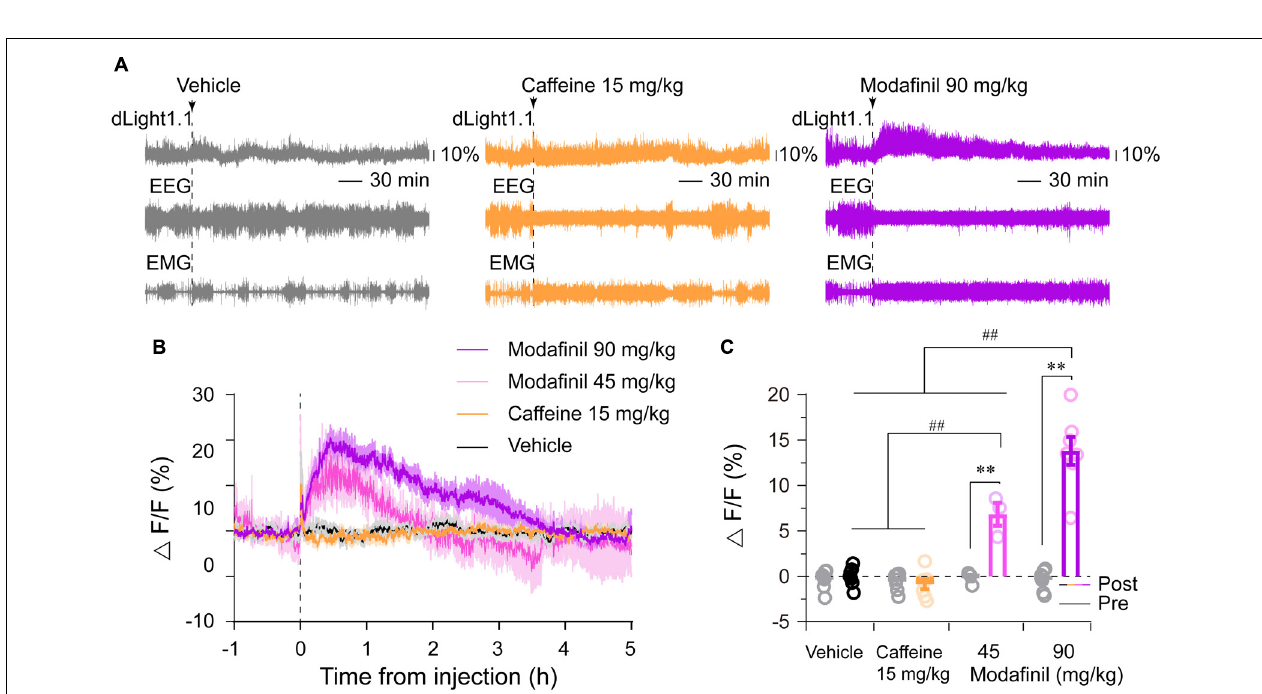
FIGURE 5 | Effects of caffeine (15 mg/kg) and modafinil (45 and 90 mg/kg) on the striatal dLight1.1 fluorescent signal. (A) Typical examples of the striatal dLight1.1 fluorescent signal, EEG, and EMG traces following vehicle (10% DMSO), caffeine, and modafinil administration. (B) Time courses of the striatal dLight1.1 fluorescent signal following vehicle, caffeine, and modafinil administration. (C) Average striatal dLight1.1 fluorescent signal in the 1 h before (gray circle and bar) and 2 h after each administration. Two-way ANOVA between time and stimuli: F 1 , 20 (time) = 147.5142, P < 0.0001, pre–post comparisons followed by Bonferroni’s test: ∗∗ P < 0.0001; F 3 , 20 (stimuli) = 29.5910, P < 0.0001. Stimuli comparisons followed by Sidak’s test: ## P < 0.0001).